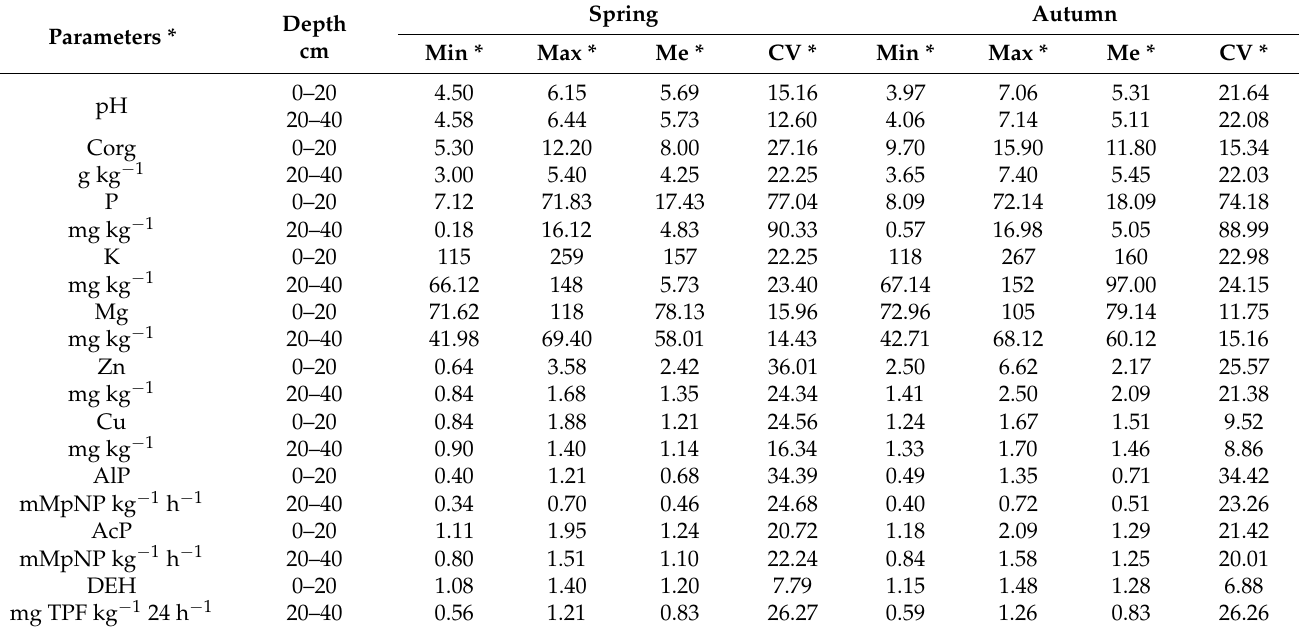
Table 3. Selected physicochemical and biochemical properties of the soil in the first year after the application of the stillage